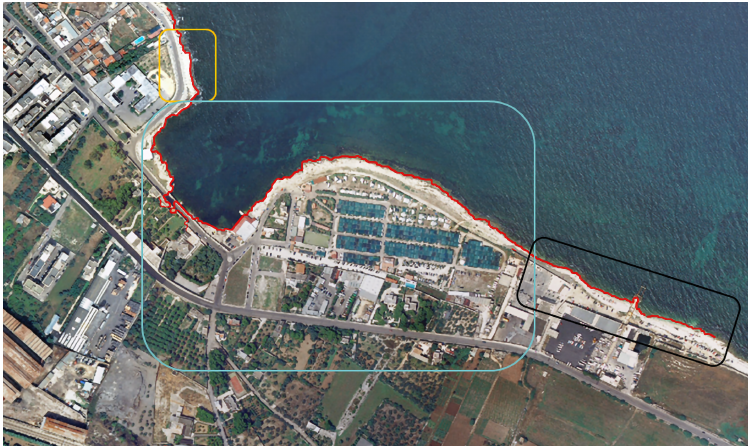
Figure 11. Example of the shoreline extracted along Apulian beaches overlapped on ortho-images. The yellow box delimits the breakwaters zones, the blue box marks the rocky beaches and the black box delimits sandy beaches limits.